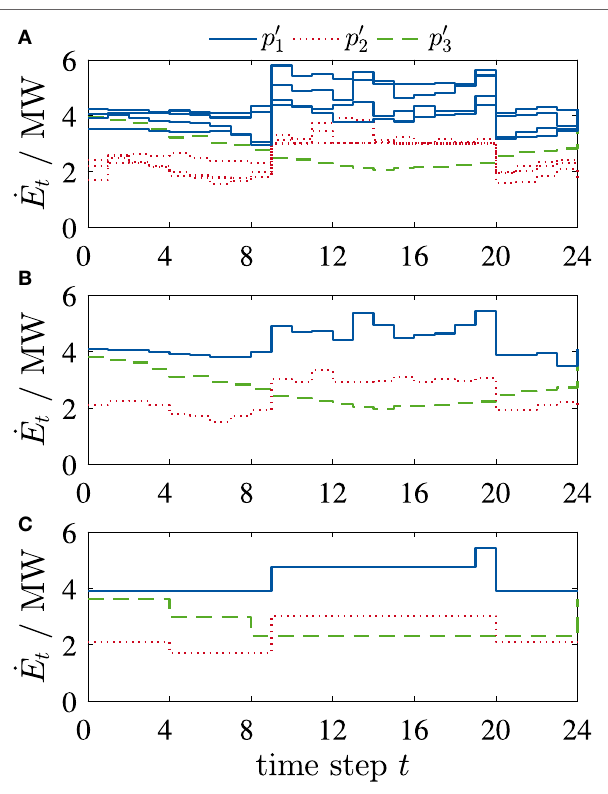
FIGURE 3 | Illustrative time-series aggregation of N TS = 1 time series of an energy demand ˙ E t with N t = 216 time steps: (A) time-series splitted in N k = 8 periods P with N j = 24 segments each. (B) Aggregation of periods P to N k ′ = 3 typical periods P ′ . (C) Aggregation of N j = 24 segments to N j ′ = 3 segments per typical period; segments do not start/end at 0h. The line style of the periods in (A) indicates the clustering assignment to the typical periods p ′ 1 ; p ′ 2 ; and p ′ 3 in panels (B,C)